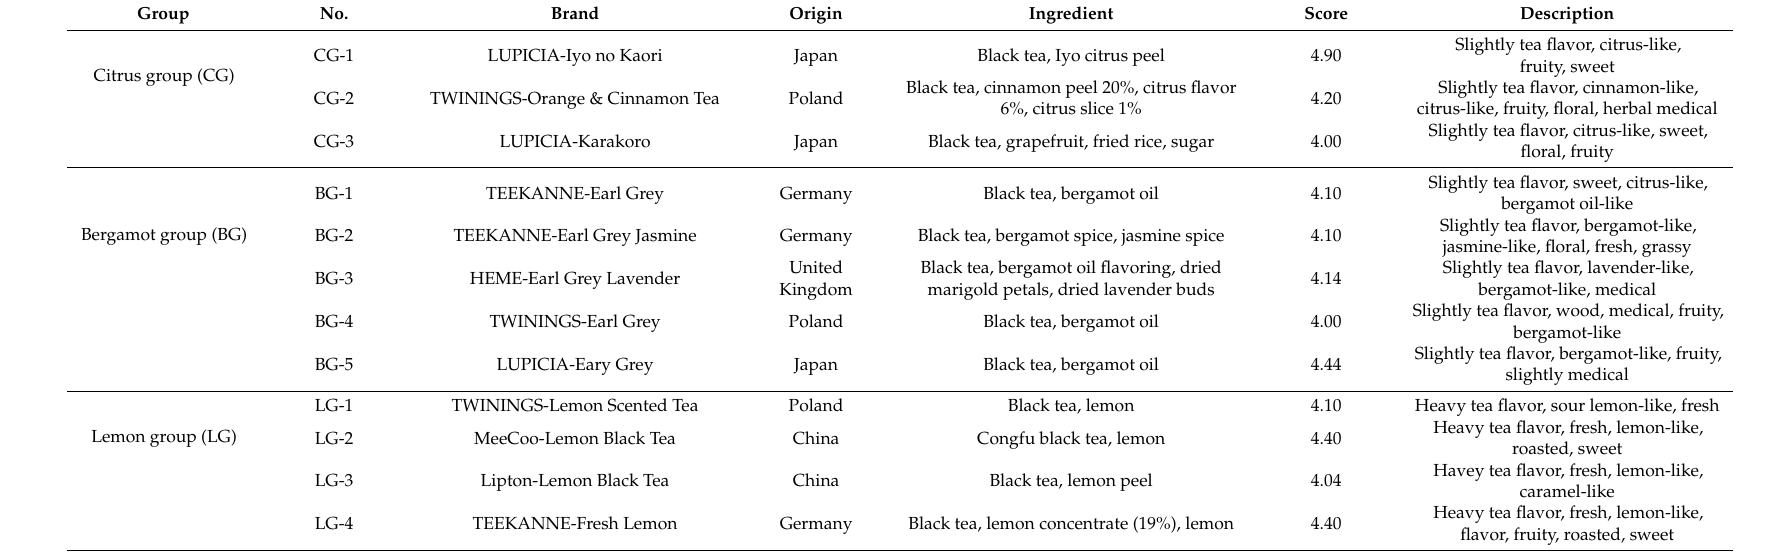
Table 1. Information and sensory evaluation of 12 typical citrus blend black